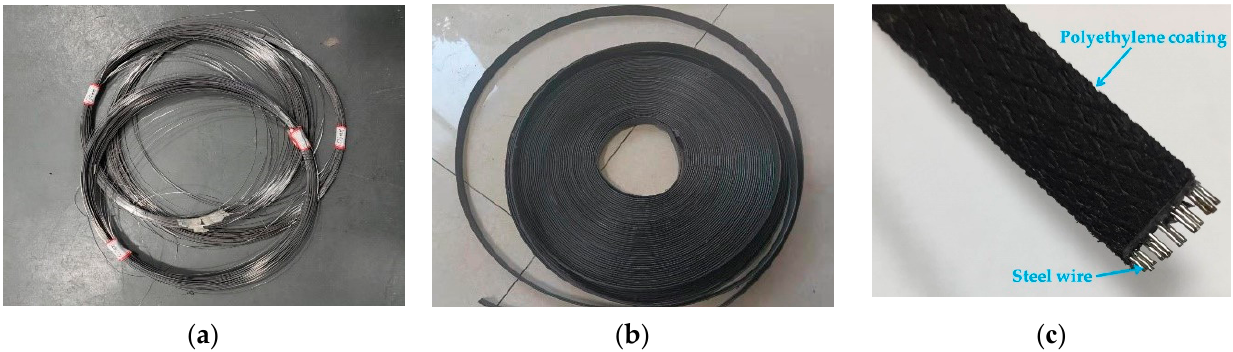
Figure 3. Sample images of the test materials: ( a ) steel wire; ( b ) polyethylene geogrid belt; ( c ) steel–plastic compound geogrid-reinforced belt.